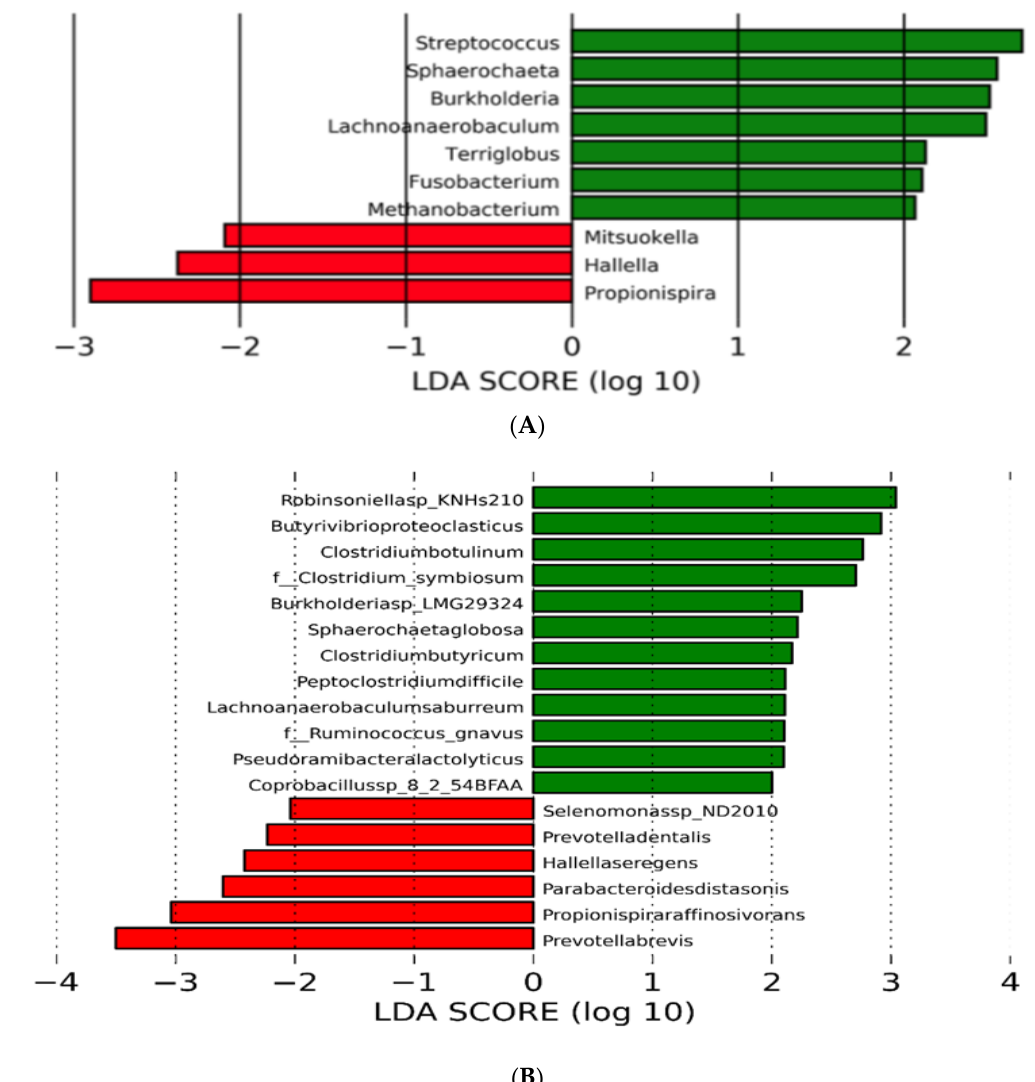
Figure 1. Linear discriminant analysis effect size (LEfSe) of rumen microbiota of beef steer fed no (control) or 200 mg/d of monensin. The linear discriminant analysis plot indicates the most differentially abundant taxa found by ranking according to their effect size ( ≥ 2.0) at the genus ( A ) and species level ( B ). The taxa enriched in steers fed the control diet are indicated with a positive score (green), and taxa enriched by the monensin treatment have a negative score (red). Only taxa meeting the significant threshold of 2.0 are shown.